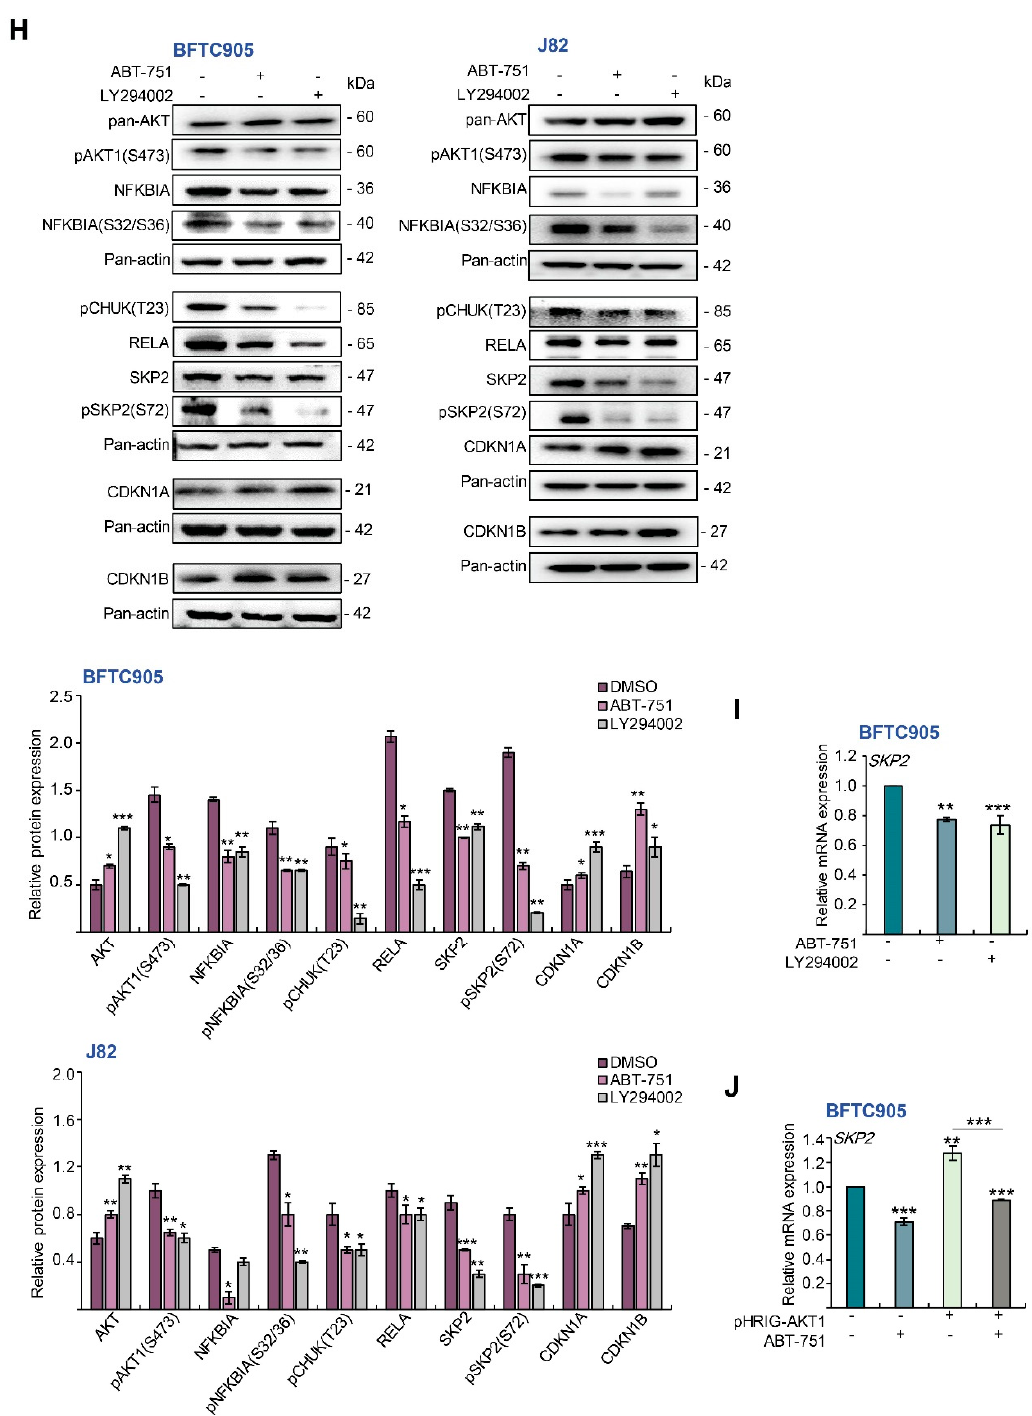
Figure 4. ABT-751 inhibits SKP2 transcription and subsequent translation in UBUC cells through dysregulation of the AKT–CHUK–NFKBIA–NFKB signaling pathway. ( A ) BFTC905 cells were treated with ABT-751 (0.6 µ M) for 24 h and the levels of the components of SKP2 E3 ligase (CDC20 and FZR1 proteins) were determined by immunoblots. ( B ) The cells were pretreated with 4 µ M of MG132, a proteasome inhibitor, for 6 h, then treated with a specified concentration of ABT-751 (BFTC905, 0.6 µ M and J82, 0.7 µ M) for another 18 h. Next, nuclear/cytosol fractionation along with immunoblot analysis were performed. ( C ) The mRNA levels of SKP2 , TP 53, CDKN 1 A , CDKN 1 B , RB 1, E 2 F 1 and TFDP 1 were analyzed by quantitative RT-PCR. ( D ) The expression levels of the SKP2 gene regulator-associated proteins were determined by immunoblots in BFTC905 and J82 cells. Cells were treated with a specified concentration of ABT-751 (BFTC905, 0.6 μ M and J82, 0.7 μ M) for 24 h, ( E ) AKT1 kinase activity via a co-immunoprecipitation assay and ( F ) nuclear/cytosol fractionation along with immunoblot analysis were performed. ( G ) The cells were treated with a specified concentration of ABT-751